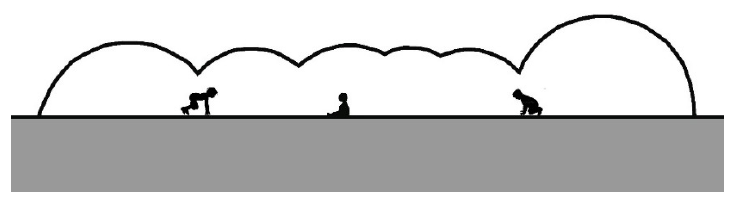
Figure 23. Playground mounds constructed from adobe—section.